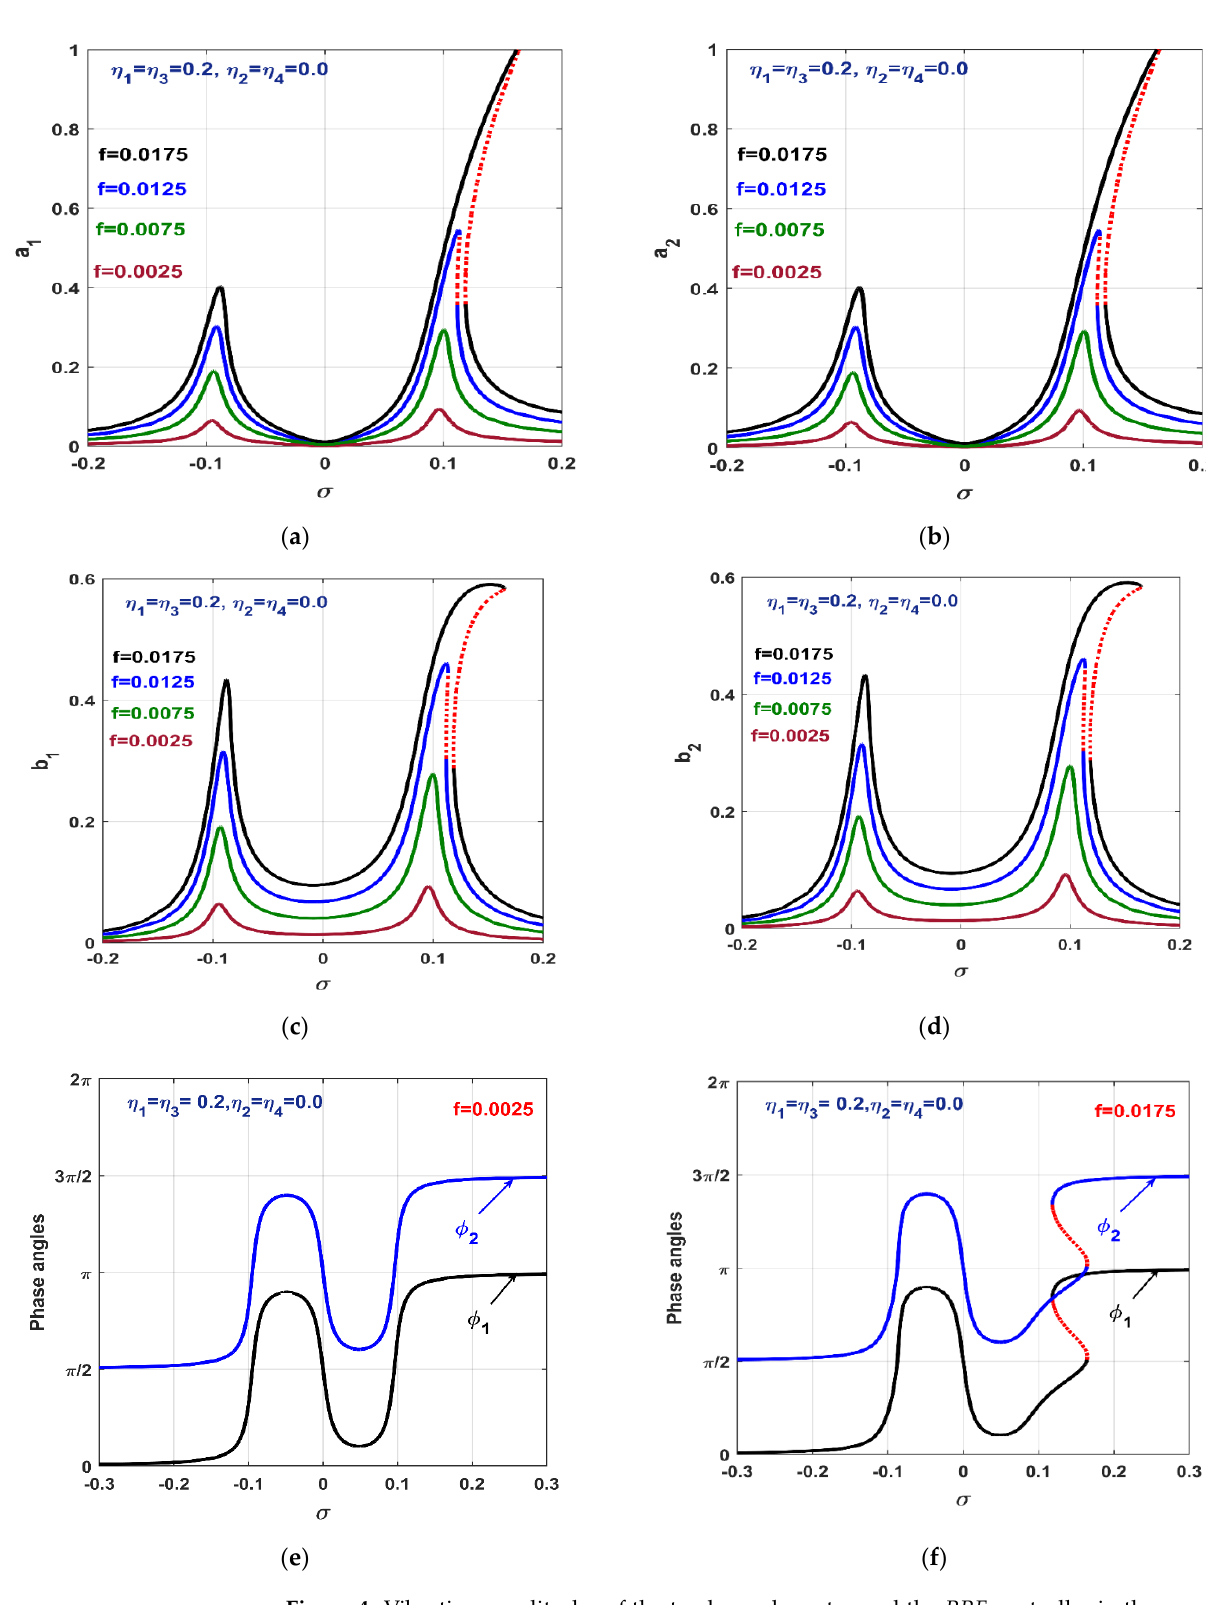
Figure 4. Vibration amplitudes of the twelve-poles rotor and the PPF controller in the case of the PD + PPF -control algorithm when f = 0.0025, 0.0075, 0.0125, and 0.0175: ( a , b ) vibration amplitudes ( a 1 , a 2 ) of the rotor, ( c , d ) vibration amplitudes ( b 1 , b 2 ) of the PPF controller, ( e ) phase angles ( φ 1 , φ 2 ) when 𝑓 = 0.0025 , and ( f ) phase angles ( 𝜙 (cid:2869) , 𝜙 (cid:2870) ) when 𝑓 = 0.0175 .